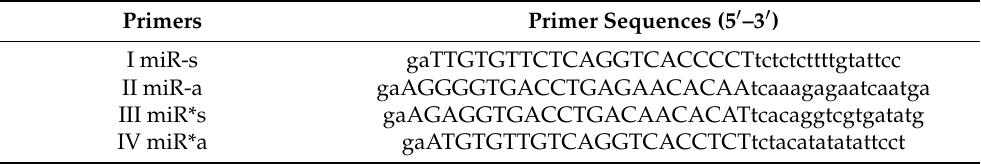
Table 1. Primers for stu-miR398b-3p .